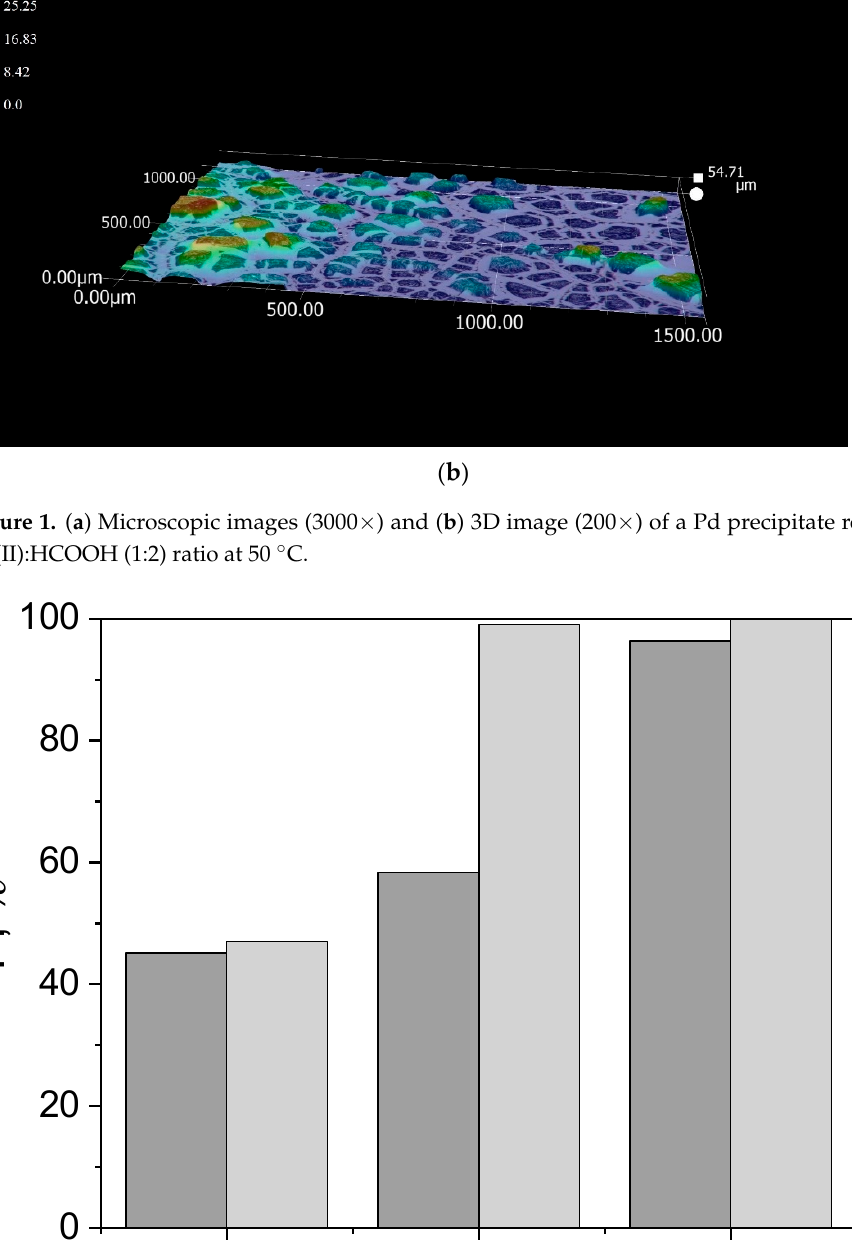
Figure 2. Influence of the pH of the solution on the efficiency of precipitation of Pd with 4 mM HCOOH at ( ■ ) 23 and ( ■ ) 50 °C.